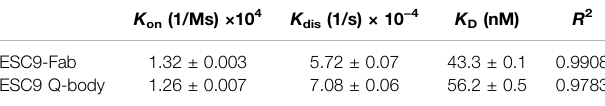
TABLE 2 | Kinetic parameters of ESC9 Fab and Q-body for E2-binding. K on (1/Ms) ×10